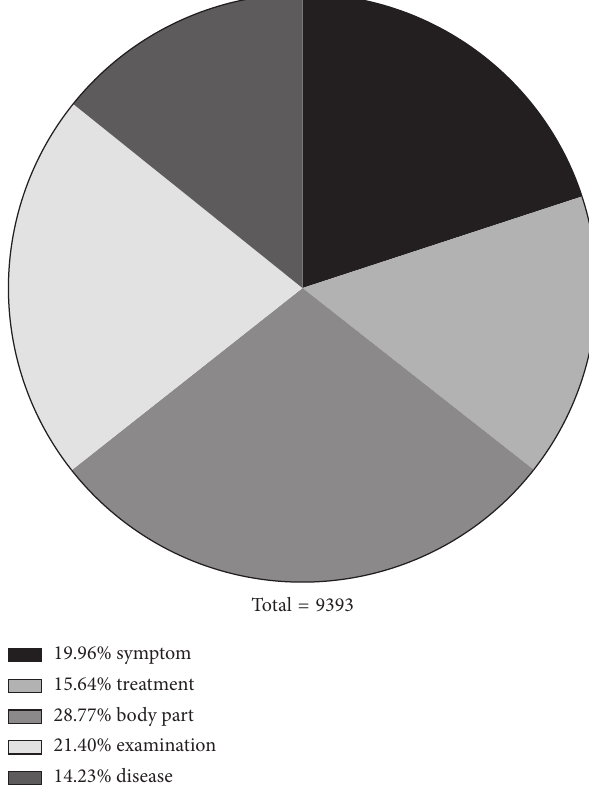
Figure 8: Distribution of various